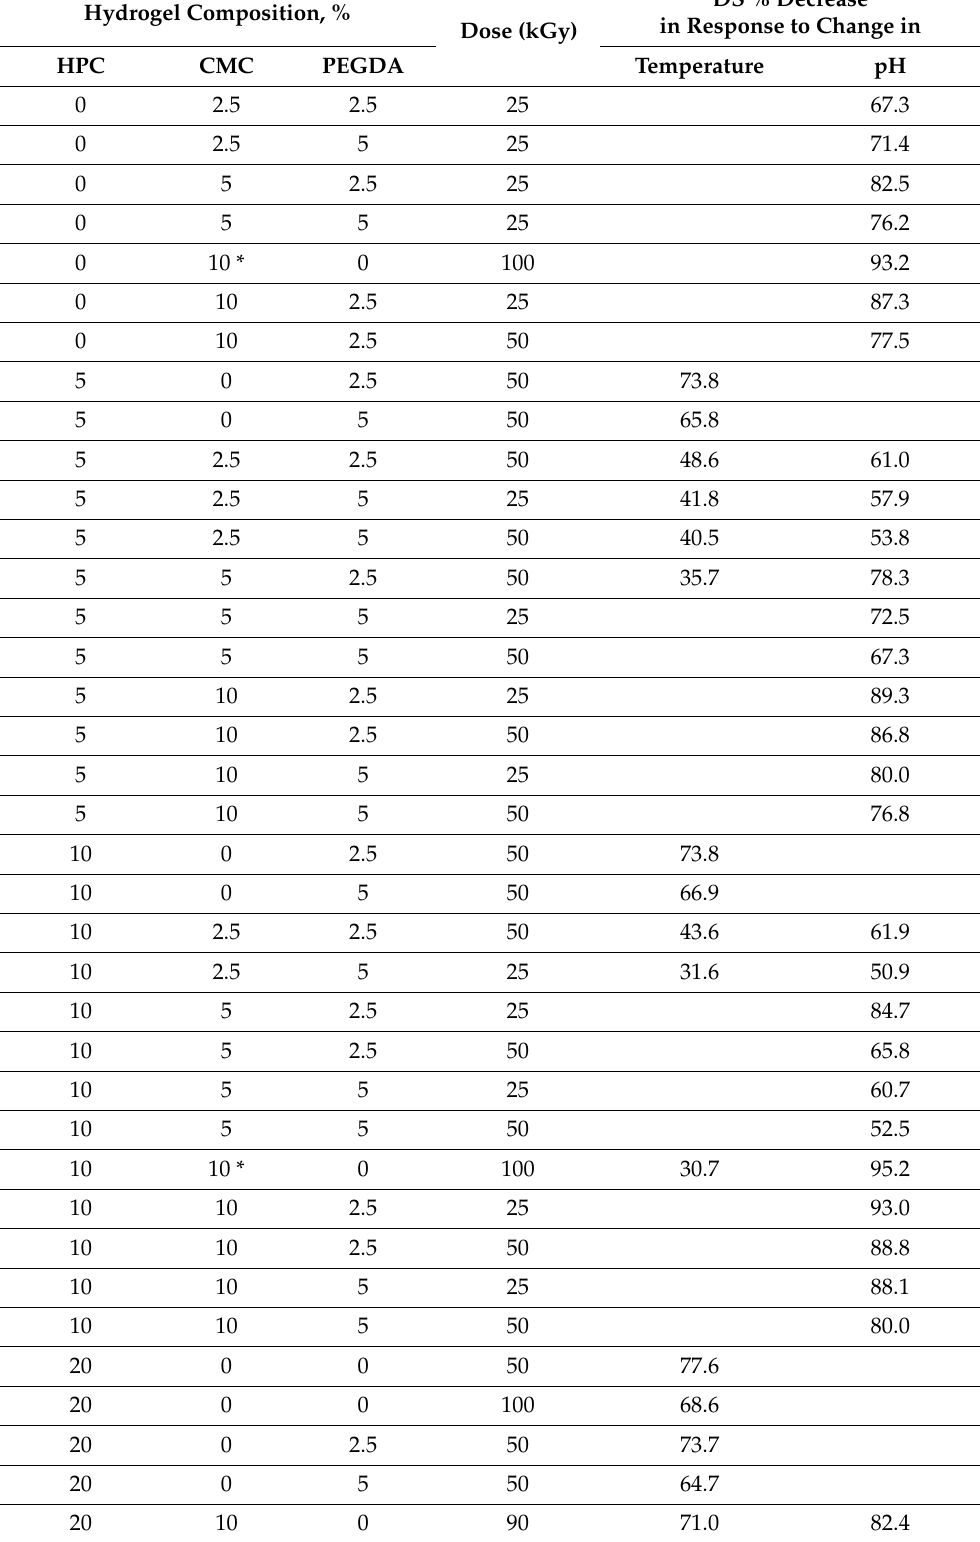
Table 2. Change in DS of the HPC and CMC hydrogels formed with or without PEGDA in response to an increase in temperature (room temperature to 55 ◦ C) or a decrease in pH (7 to